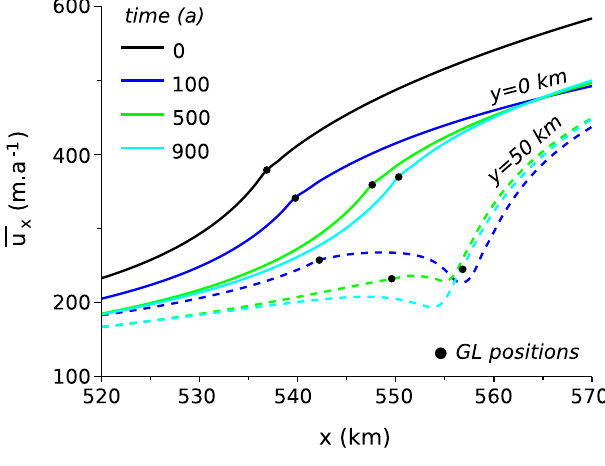
Fig. 9. Effect of the pinning point on the vertically integrated veloc- ity ¯ u x . Depicted profiles are along the symmetry plane y = 50 km (dashed lines) and along the lateral wall y = 0 km (solid lines), for t =0, 100, 500, 900 years. The position of the most landward grounding line for similar y-coordinate is also shown. A separate marker for the pinning point is not contained in this